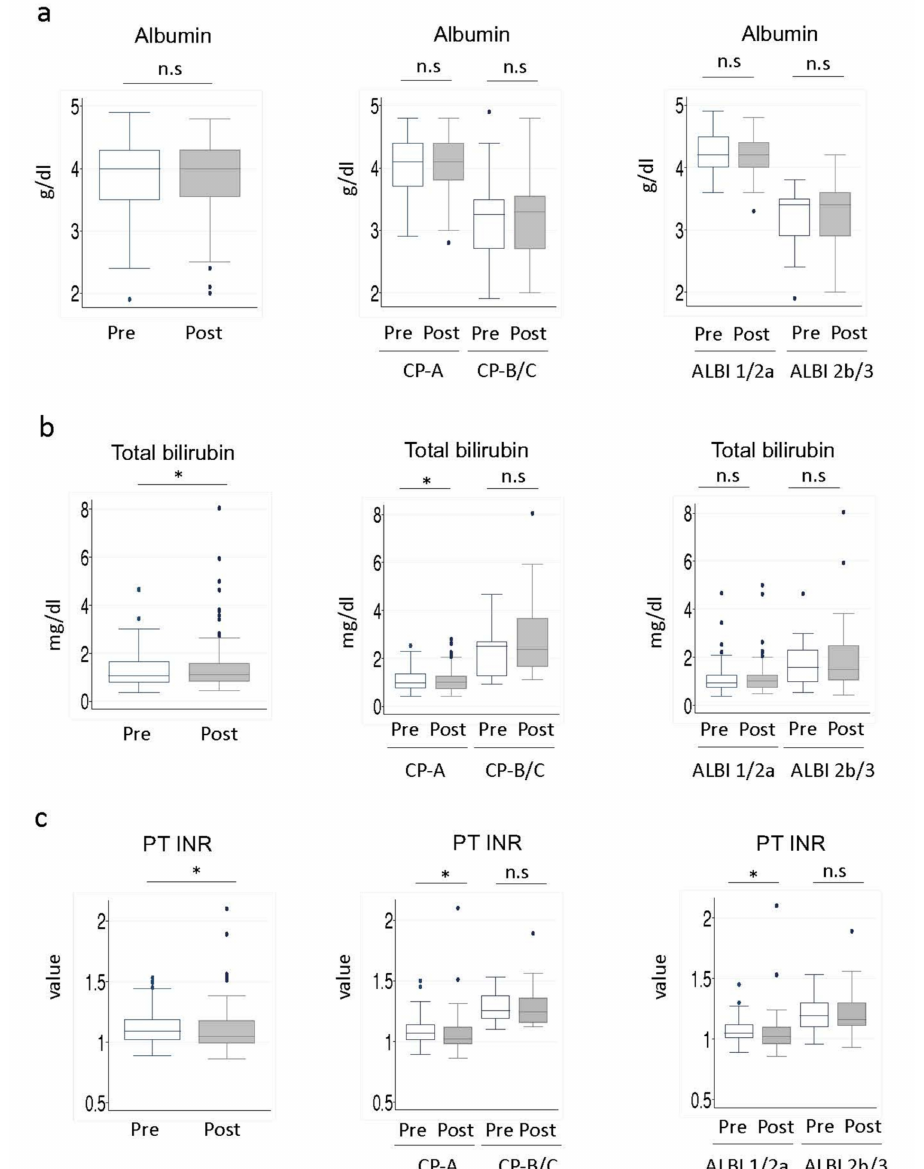
Figure 2. Changes in serum albumin (( a ), n = 124), total bilirubin (( b ), n = 125), and prothrombin-time INR (( c ), n = 110) after vaccination in patients with cirrhosis. All patients are shown in the left panel, CP class A (n = 91) and B/C (n = 20) are shown in the middle panel, and ALBI grade 1/2a (n = 82) and 2b/3 (n = 42) are shown in the right panel. *: p < 0.05, n.s.: not